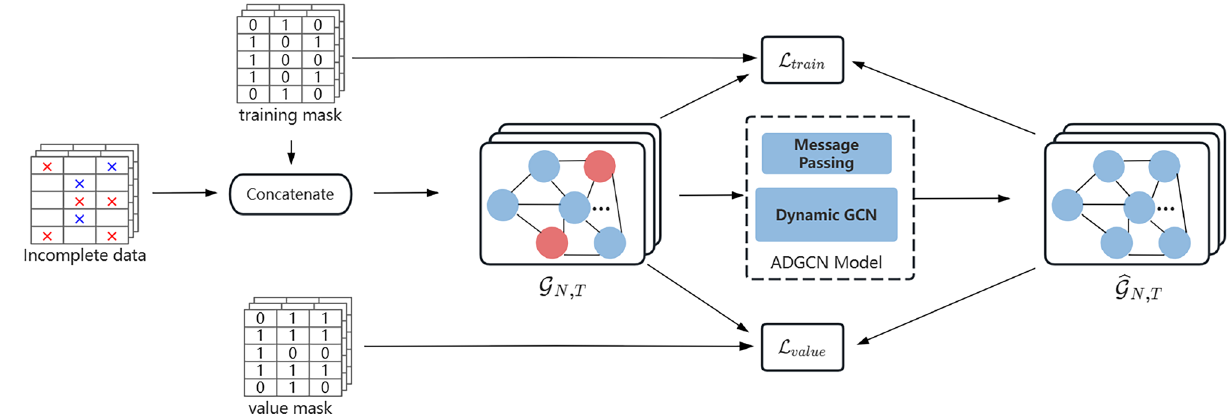
Figure 3. Description of the training method for reconstructing missing map